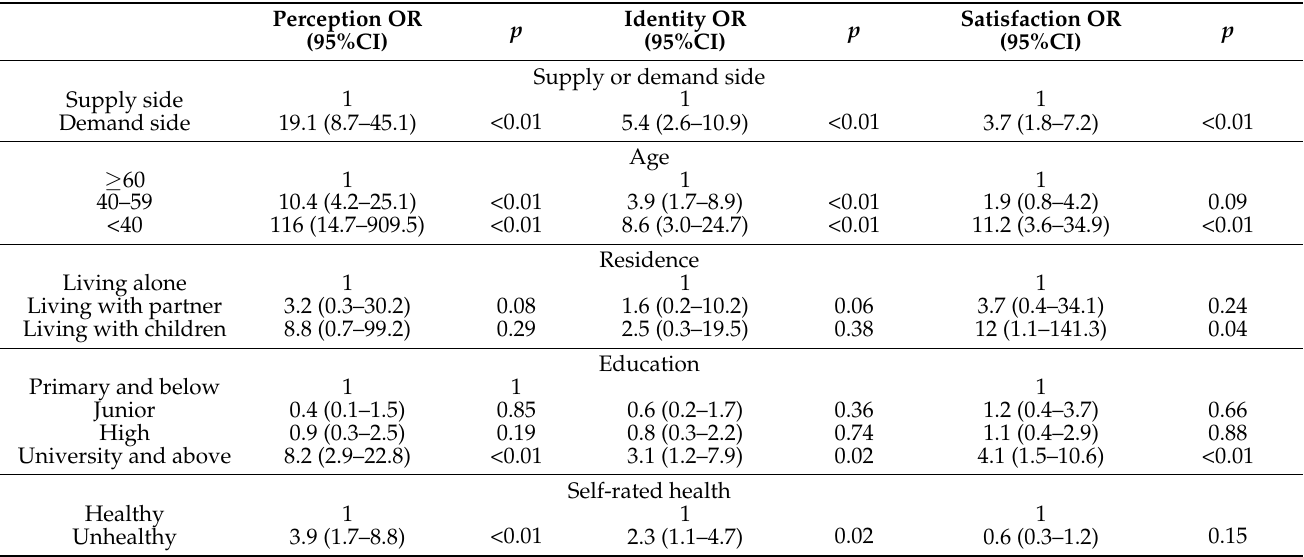
Table 4. The logistic regression analysis of perception, identity, and